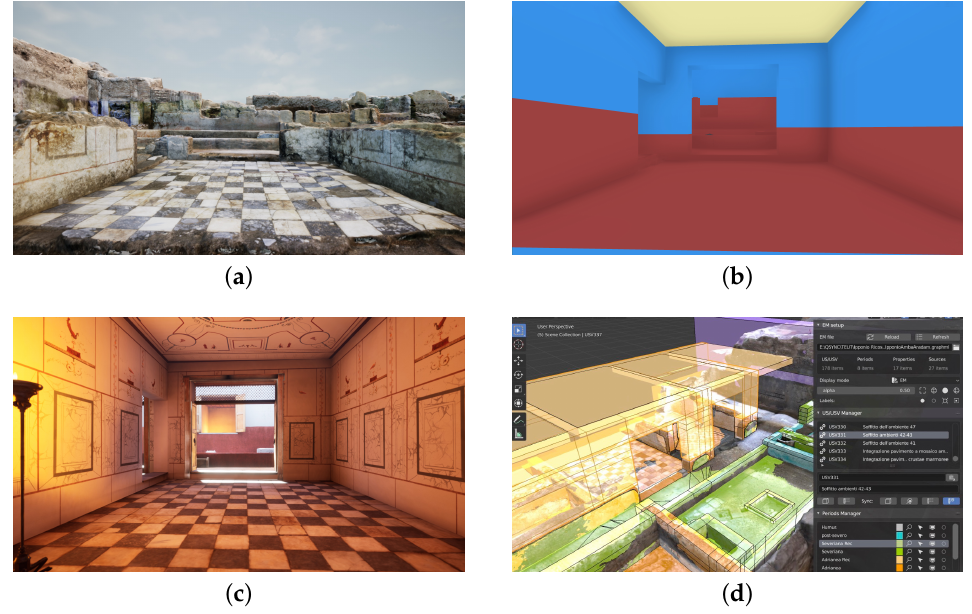
Figure 8. Digital Replica (DR, a ), Proxy model ( b ) and Representation Model (RM, c ) of the so-called Domus of the Commander from the Amba Aradam excavation. The 3d model semantic enrichment is provided through the EMtools ( d , see infra Section 5.2). See colour chart in Table